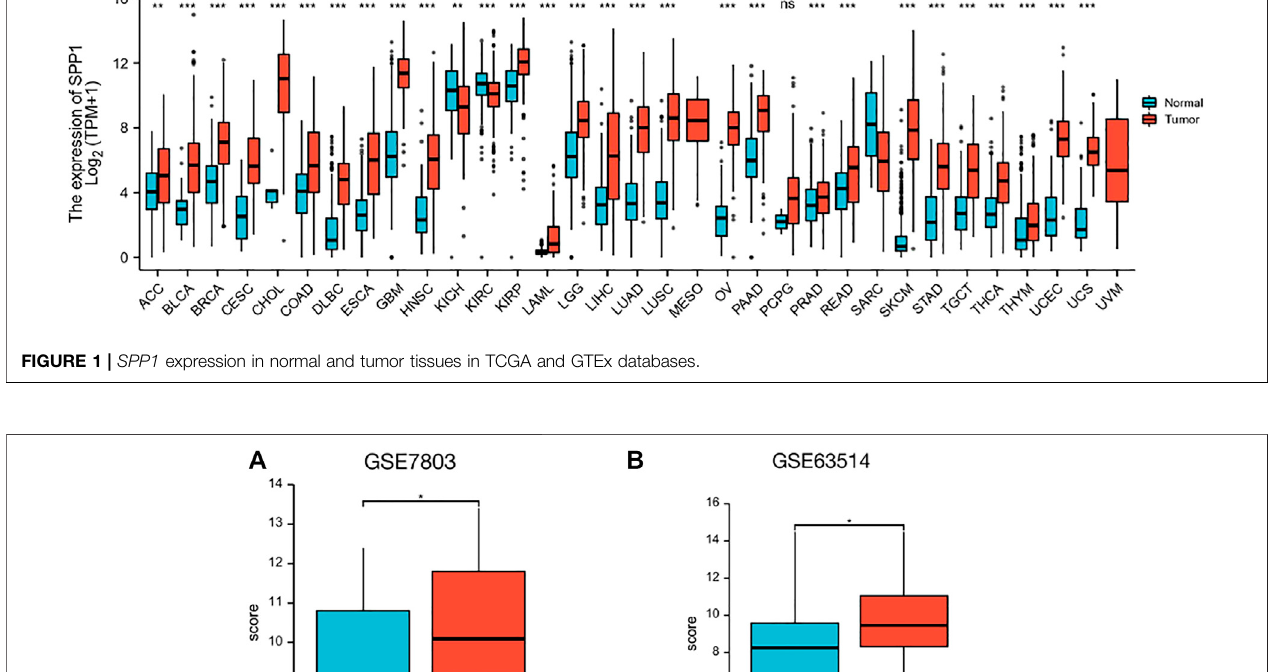
Frontiers in Genetics |